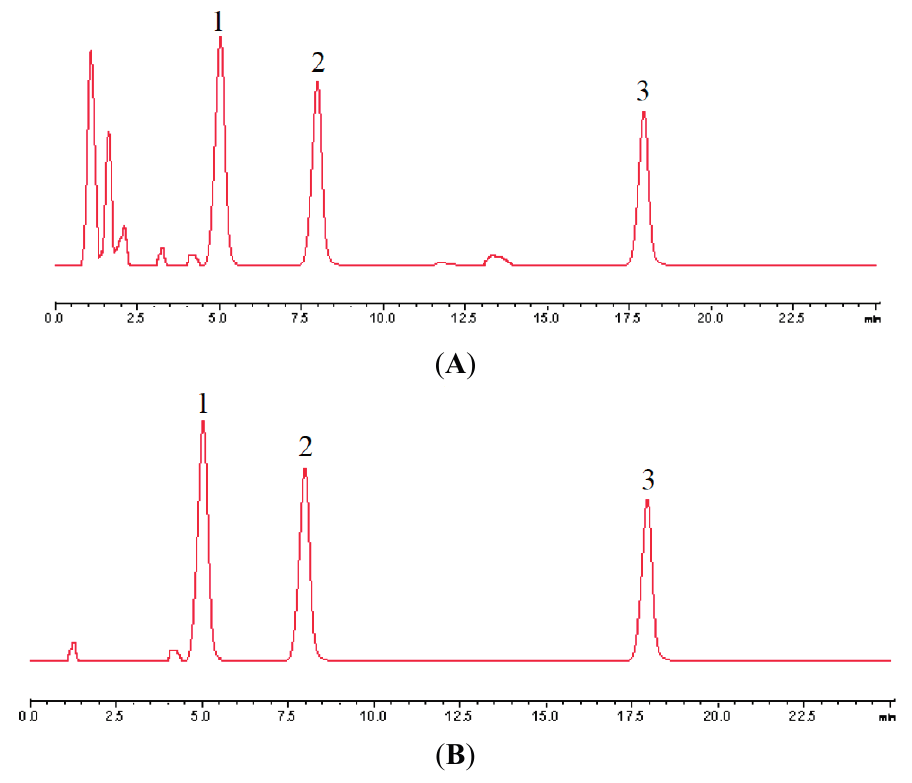
Figure 9. Chromatograms of test sample ( A ) and reference substances ( B